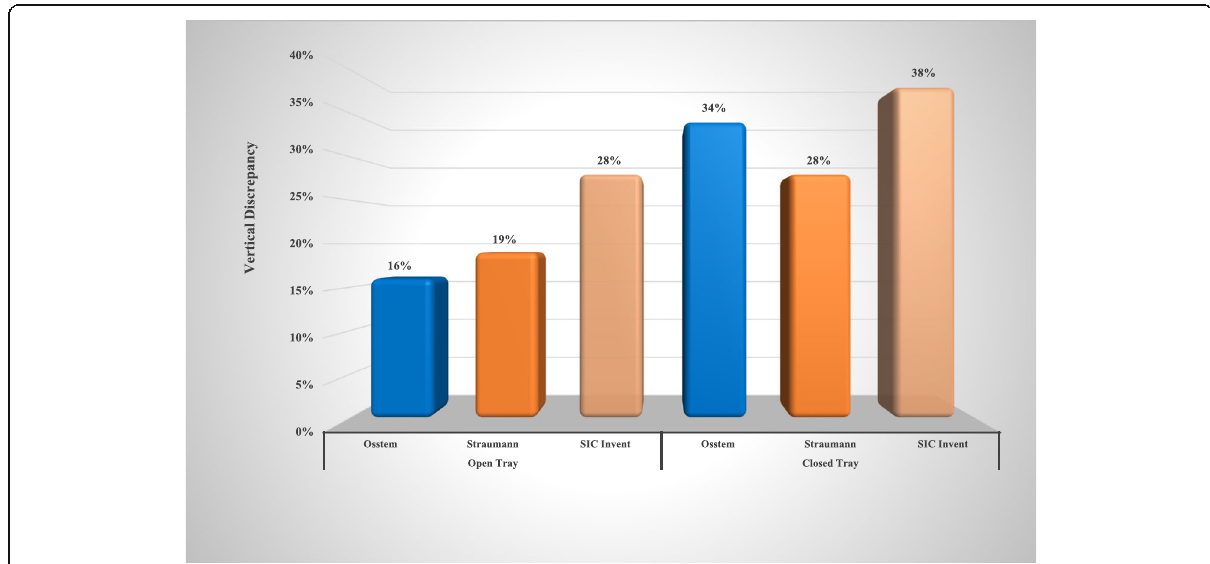
Fig. 5 Effect of implant impression techniques on the vertical discrepancy of all implant systems